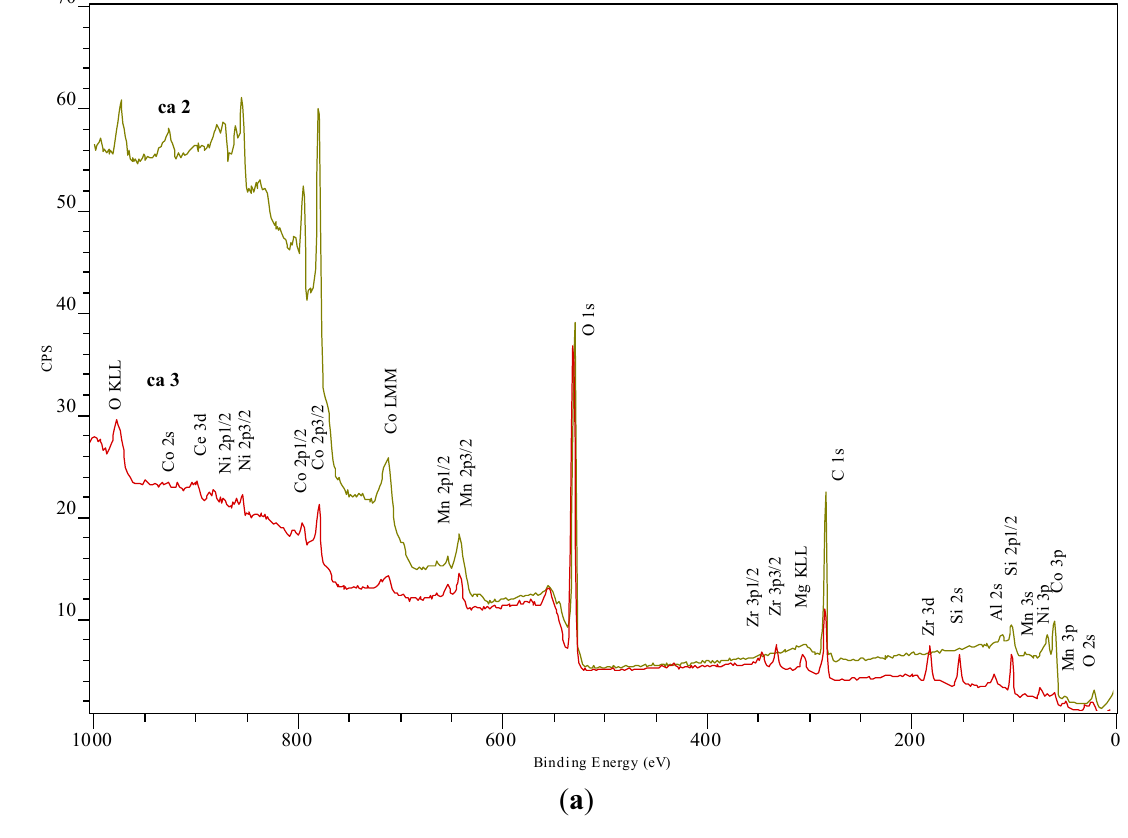
Figure 6. XPS spectra of the as-prepared sample Ca.2 (MnO and Ca.3 (MnO ( c ) Co region; ( d ) Ni–Ce region; ( e ) Zr